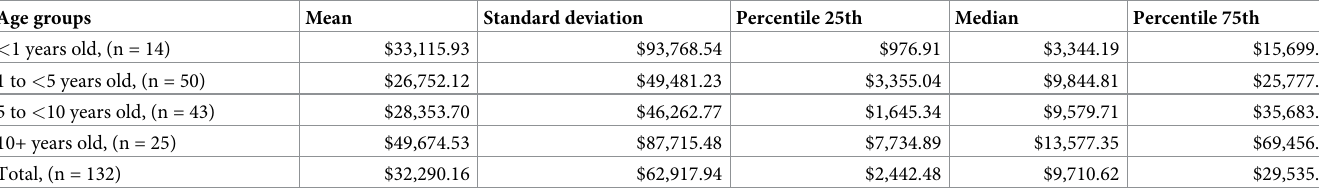
Table 5. Total costs over the three clinical areas (Emergency Room, General Ward and PICU).